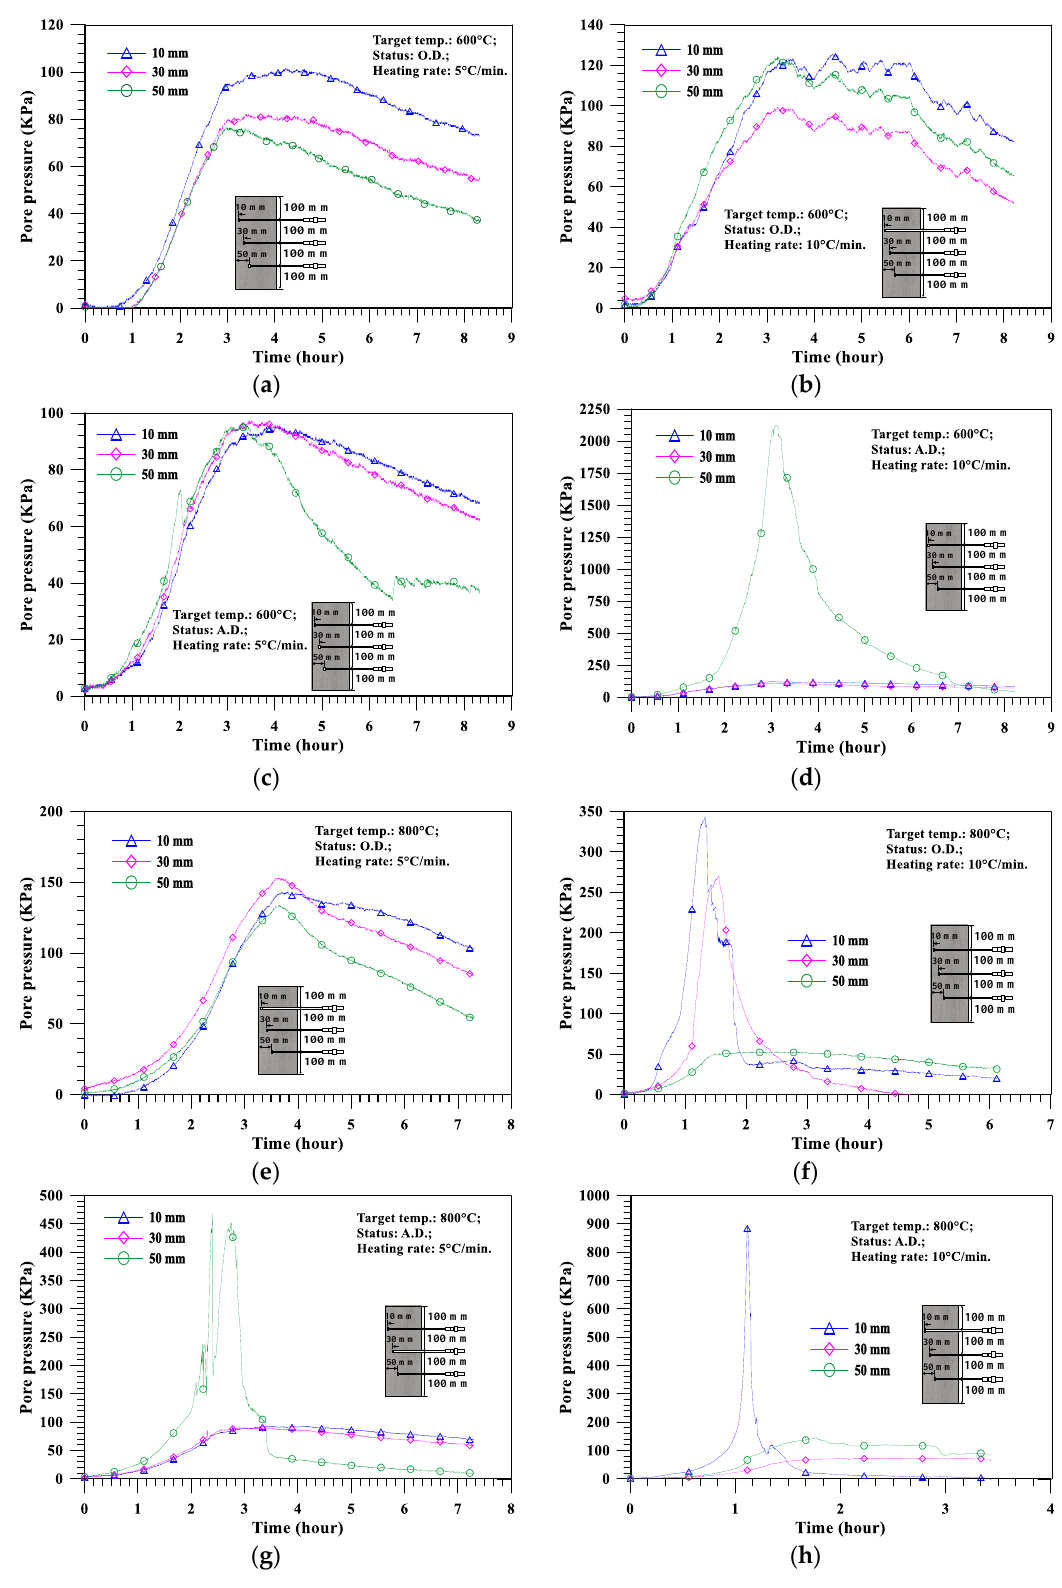
Figure 13. The build-up of pore pressure with time for the LWAC slabs: ( a ) L-OD-600-R5; ( b ) L-OD-600-R10; ( c ) L-AD-600-R5; ( d ) L-AD-600-R10; ( e ) L-OD-800-R5; ( f ) L-OD-800-R10; ( g ) L-AD-800-R5; ( h ) L-AD-800-R10.